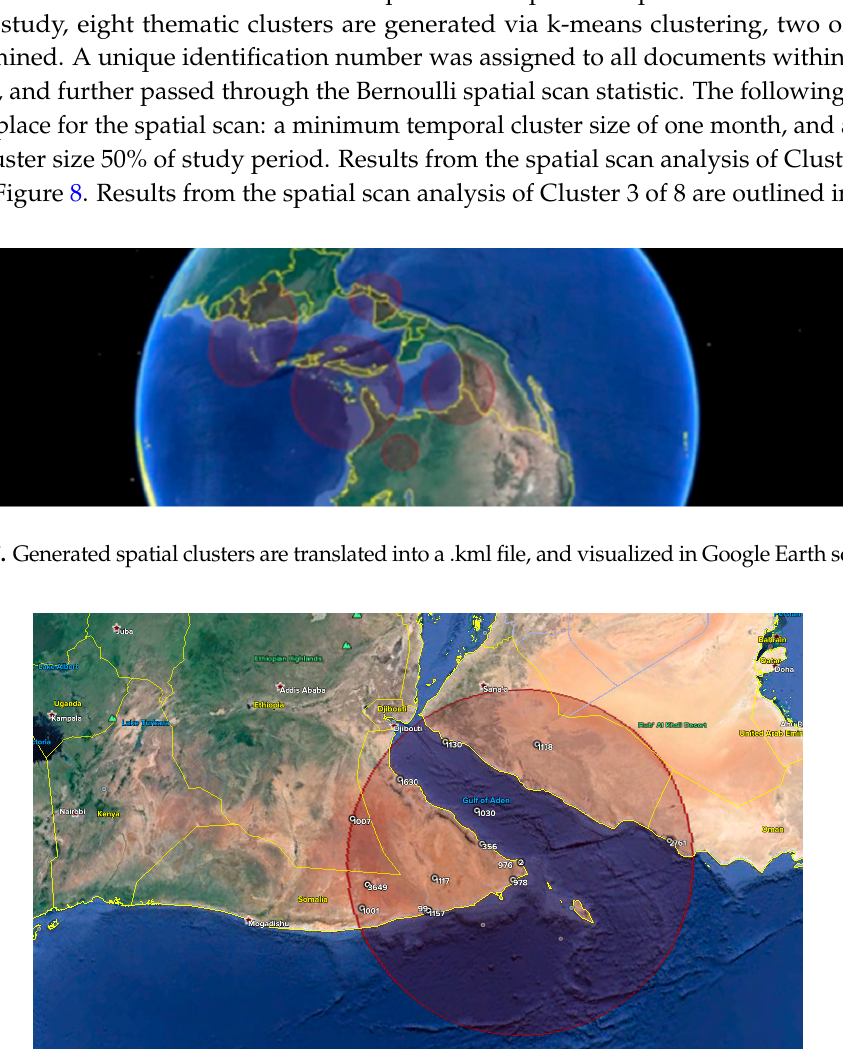
ISPRS Int. J. Geo-Inf. 2017 , 6 , 193